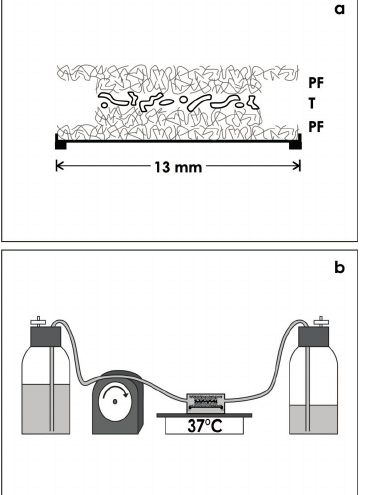
Figure 7. Schematic illustration shows generation of renal tubules within an artificial interstitium. ( a ) In present culture experiments, the isolated tissue layer containing renal stem/progenitor cells was placed between polyester fleeces and mounted in a MINUSHEET ® tissue carrier; ( b ) For subsequent culture, the tissue carrier was transferred to a perfusion culture container with horizontal flow characteristics. During a culture period of 13 days chemically defined culture medium was not re-circulated but transported from the storage to a waste